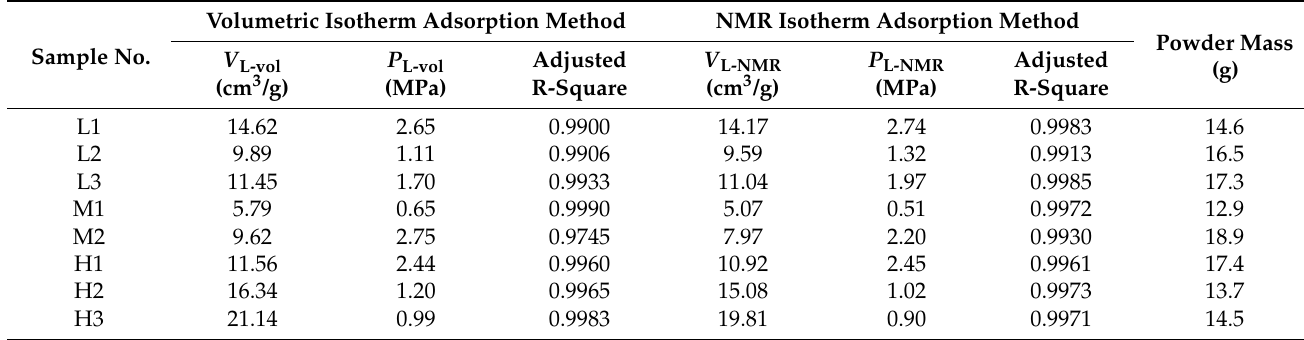
Table 2. Comparison of the Langmuir parameters determined by volumetric-based and NMR-based